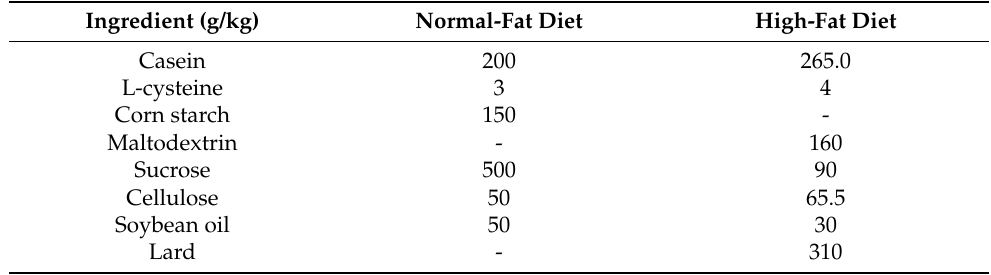
Table 4. Composition of the experimental